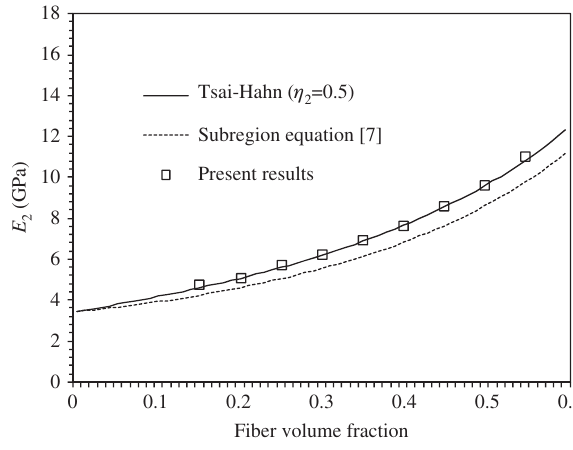
Figure 3 The variation of stress-partitioning parameters for composites samples.